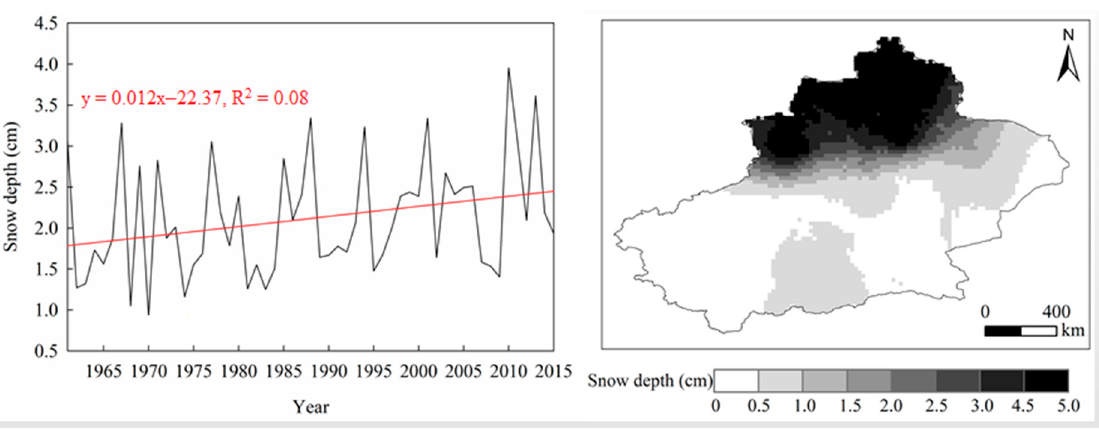
Figure 4. The temporal variations of annual snow depths (cm) over 1961–2015 and spatial distribution of long-term mean values in Xinjiang.